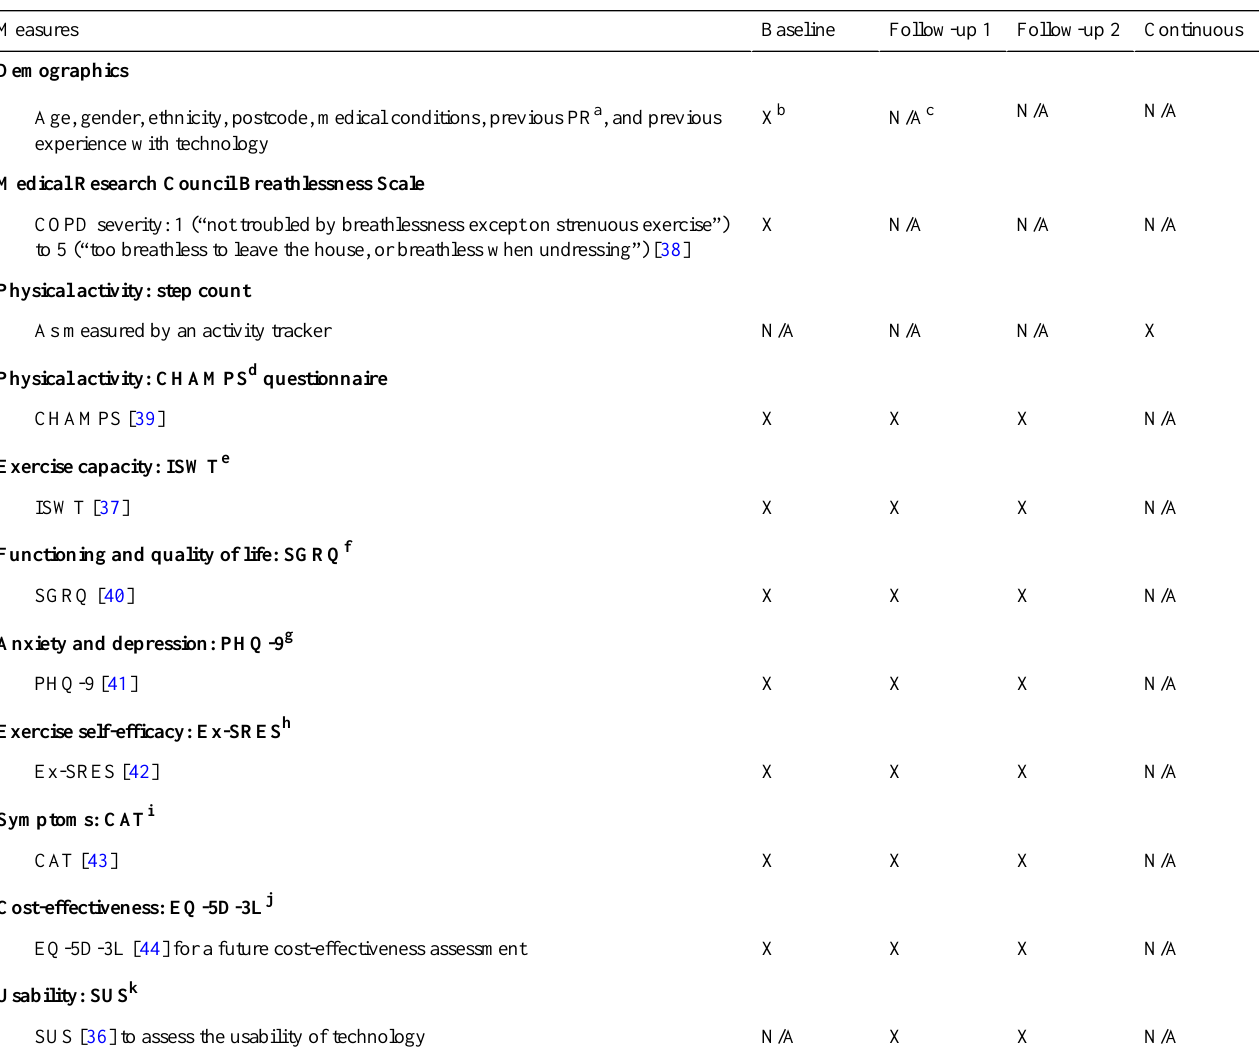
Table 2. Summary of measures taken from participants at different time